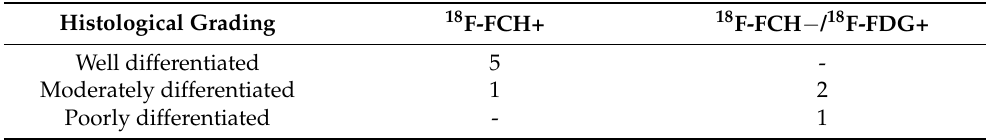
Table 2. Correlation between the results of 18 F-FCH/ 18 F-FDG PET/CT and histological findings